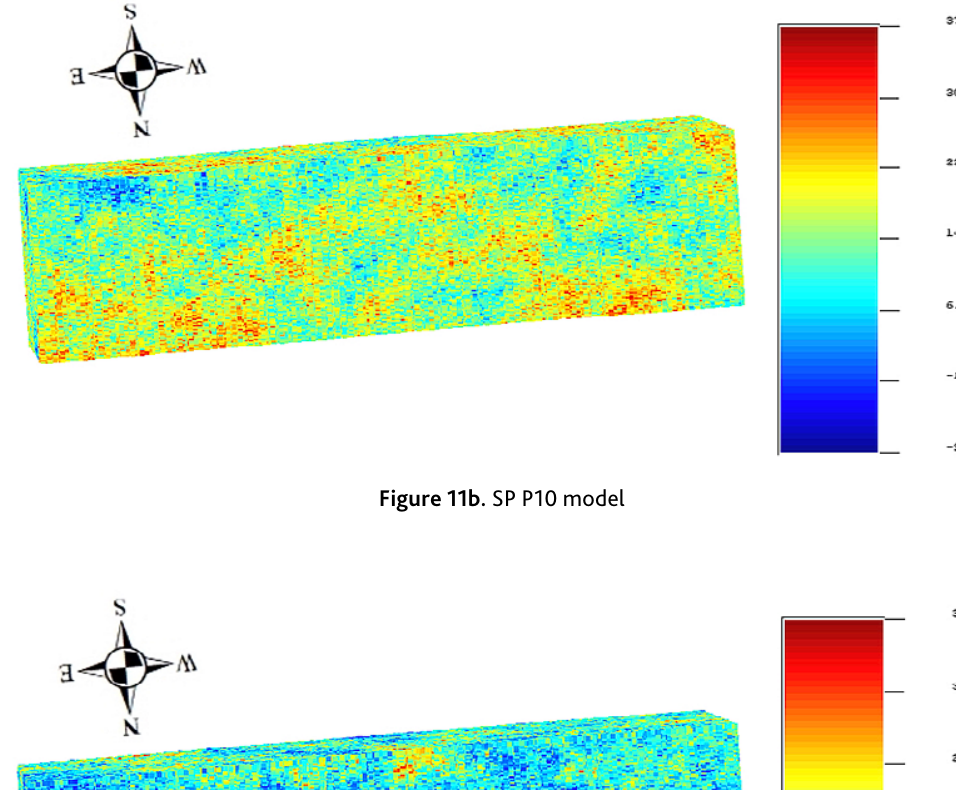
Figure 11b. SP P10 model